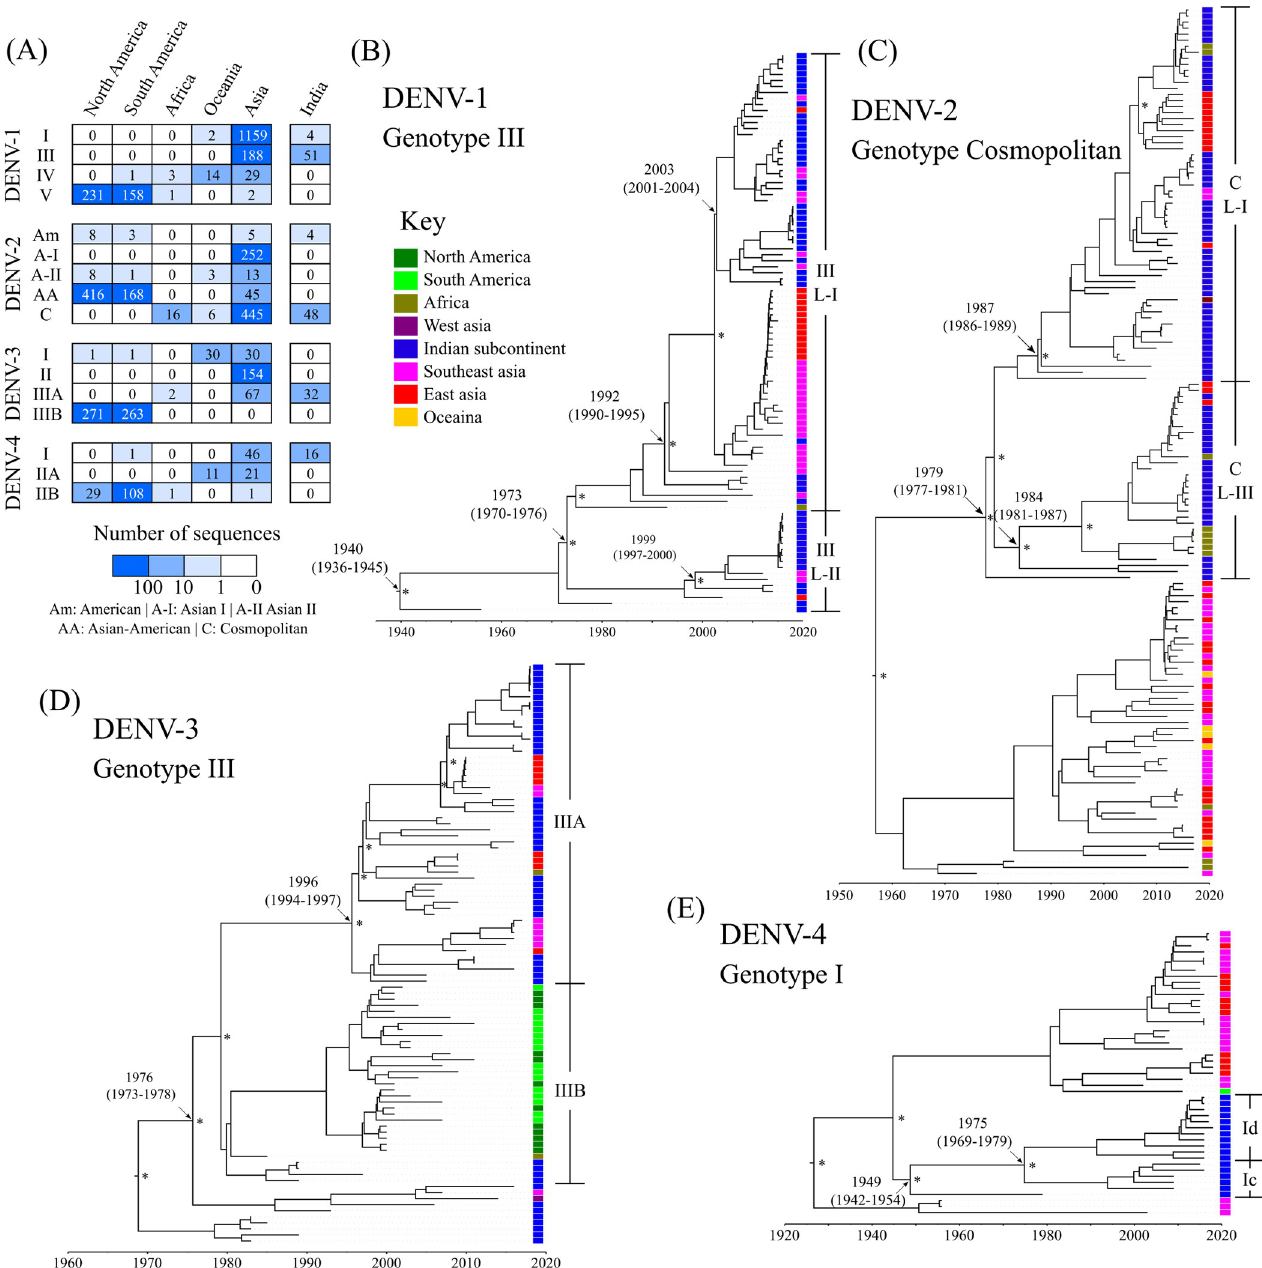
Fig 2. Dengue genotype distribution and phylogeny. (A) Heatmap of the number of whole-genome sequences from different geographical regions and India. (B-E) Time-dated phylogenetic trees for all serotypes with the circulating genotypes in India (DENV-1-III, DENV-2-cosmopolitan, DENV-3-III, DENV-4-I). The colour of the rectangle at the tip of the branches represents the region of the sample collection. The estimated time of the common ancestors is denoted for the important nodes along with the 95% highest posterior density (HPD) intervals. Asterisk ( * ) denotes posterior probability support of �